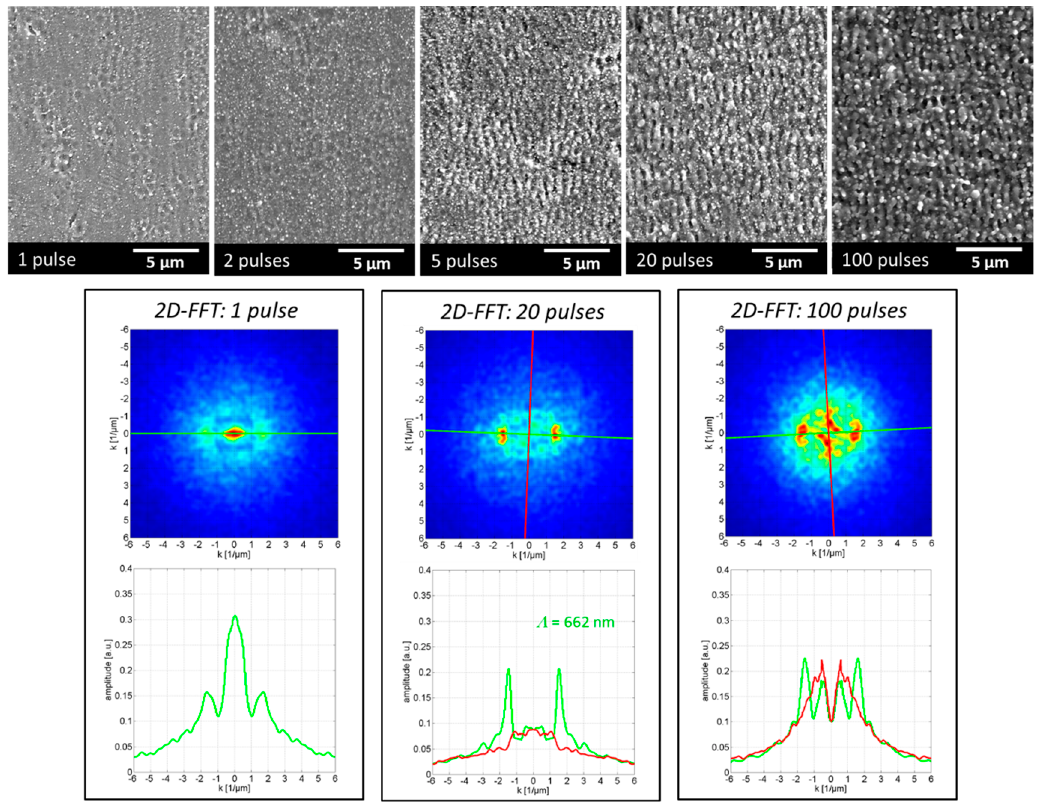
Figure 4. SEM micrographs and 2D-FFT analysis showing the development of the surface texture in the center of the laser-filament-made ablation spot at 5-meter substrate position in the filament path (55-meter beam propagation). The number of filament pulses varied.